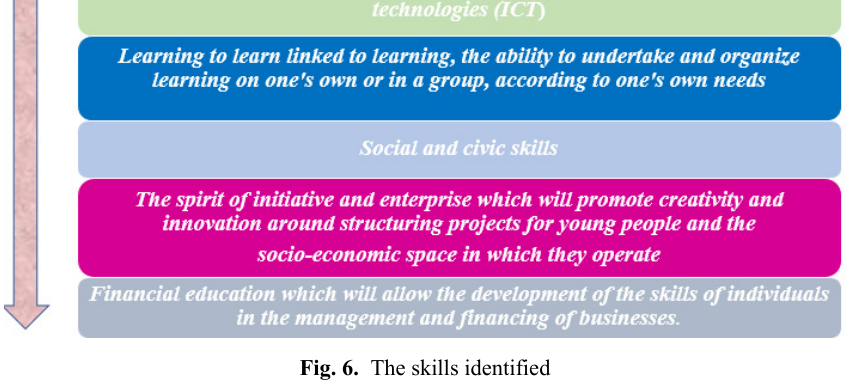
Fig. 6. The skills